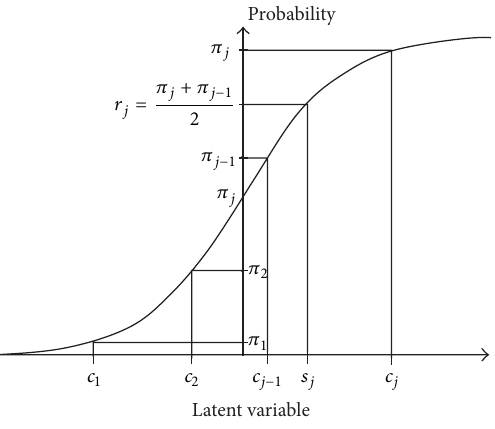
Figure 1: The correlation plot of 𝑠 𝑗 and 𝑟 𝑗 .